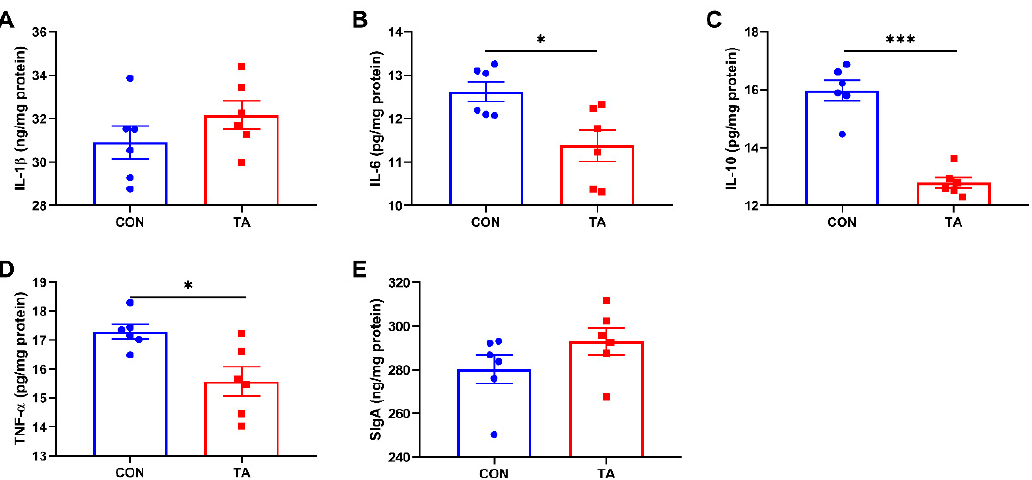
Figure 4. Effects of tannic acid extracted from Galla Chinensis supplementation on intestinal mucosal inflammatory cytokines and SIgA concentrations in broiler chickens. ( A ) Interleukin-1beta (IL-1 β ); ( B ) Interleukin-6 (IL-6); ( C ) Interleukin-10 (IL-10); ( D ) Tumor necrosis factor-alpha (TNF- α ); ( E ) Se- cretory immunoglobulin A (SIgA). CON, broiler chickens fed basal diet; TA, broiler chickens fed basal diet supplemented with 300 mg/kg microencapsulated tannic acid extracted from Galla Chinen- sis . Values are mean ± standard error ( n = 6). Differences between treatments were displayed by * p < 0.05 and *** p < 0.001.